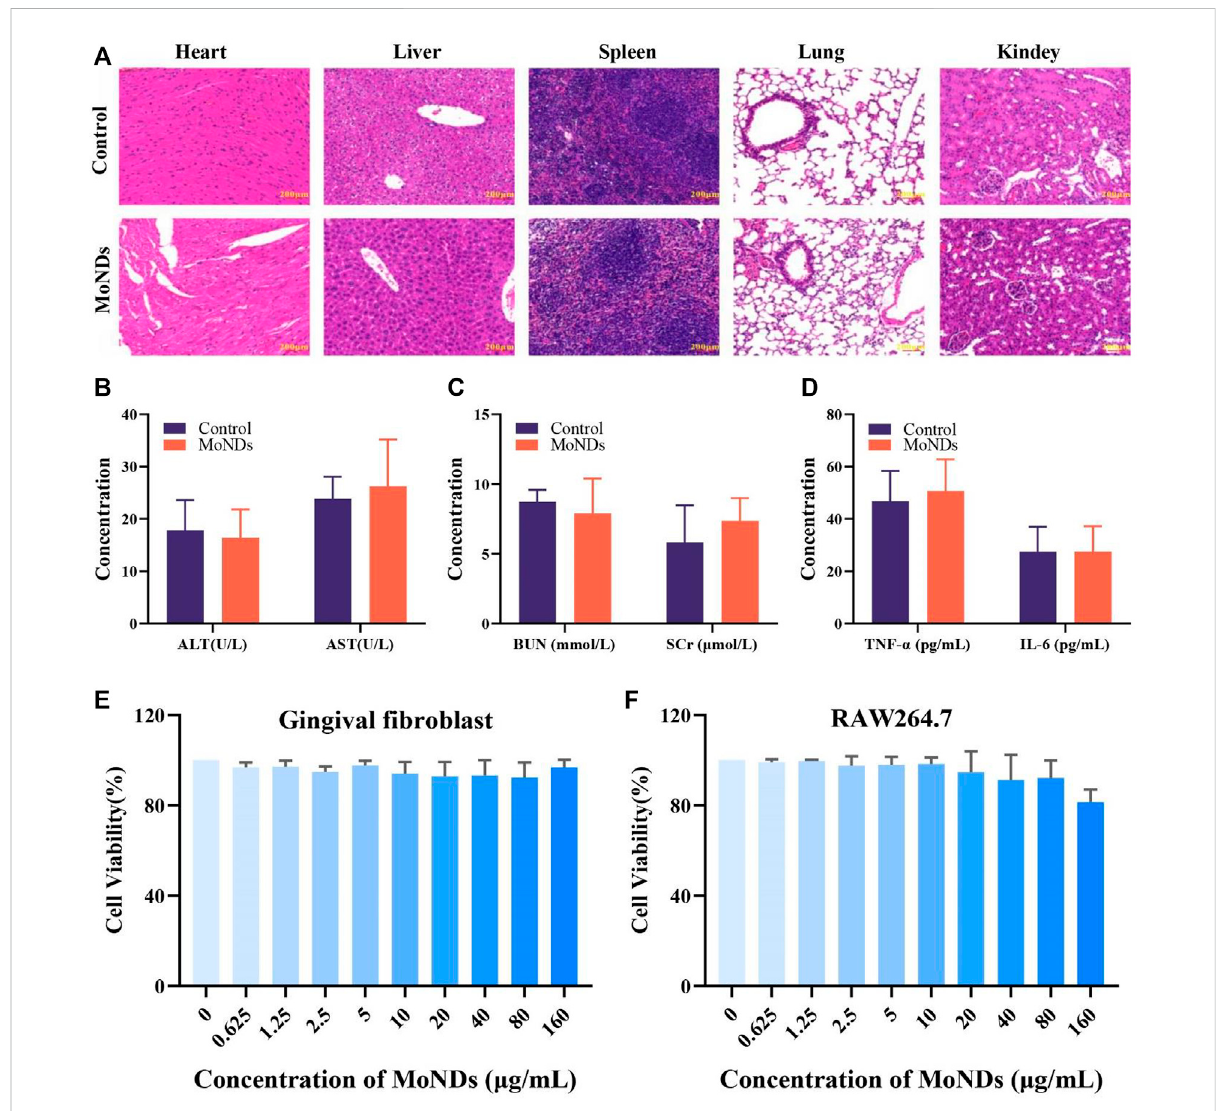
FIGURE 6 BiocompatibilityofMoND therapy. HEstainingofmajor organsonday1 (A) after theadministration.Mice wereintravenously